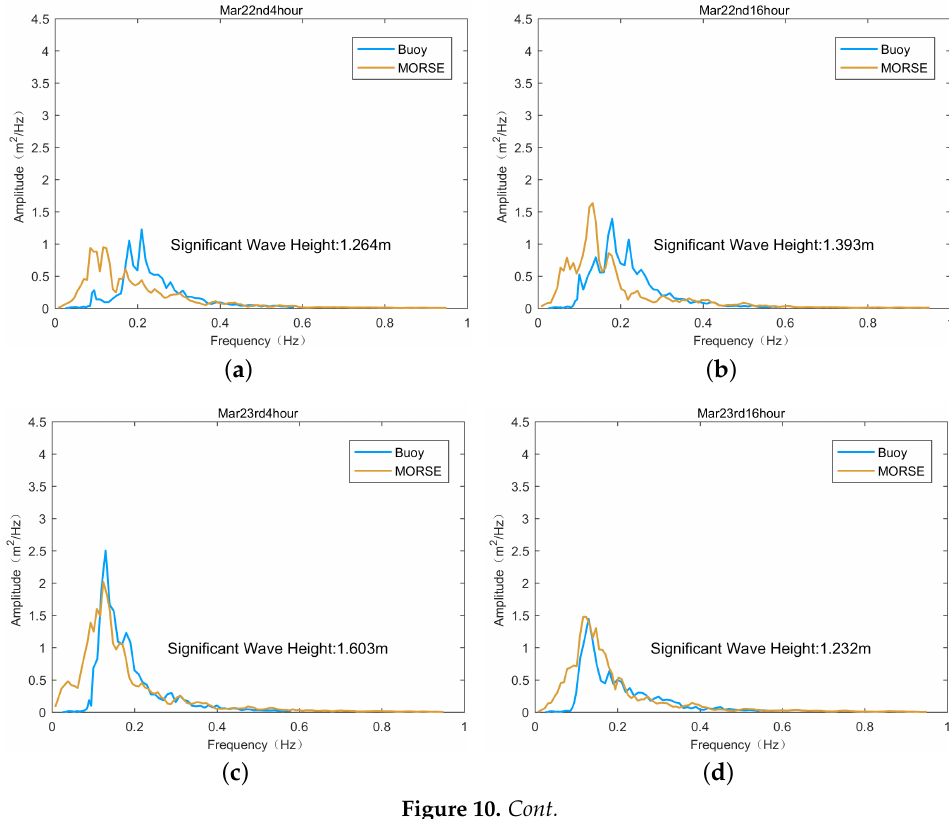
at 16:47 to 17:05 March 23. ( c ) Normalized echo energy density acquired with No.5 antenna at 04:59 March 25. ( d ) Directional wave height spectrum at 04:53 to 05:11 March